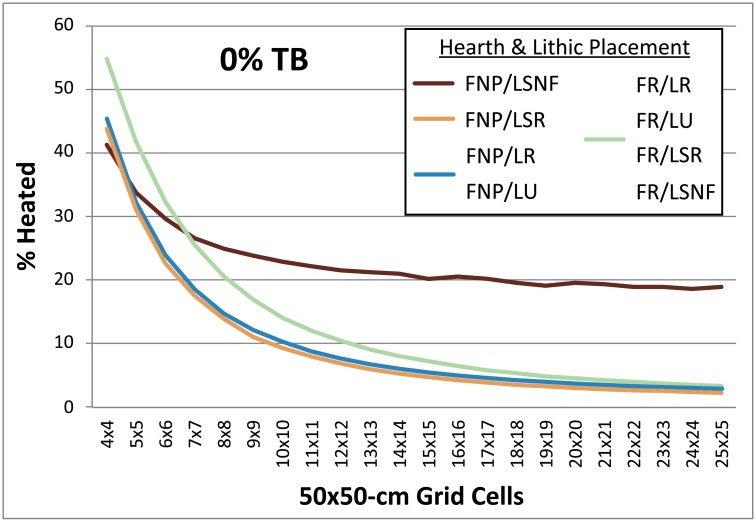
Chart comparing occupation surface size and various fire and lithic scatter placement scenarios.Parameters: 1 fire, fire size 1, 4 lithic scatters, 30 occupations, 1% introduced lithics. Given the near identical results obtained for simulations using the FNP/LR and FNP/LU settings (blue), as well as for all simulations using the FR setting (green), for the sake of clarity these are shown here as single curves. FNP = Fire near previous, FR = Fires random, LSNF = Lithic scatters near fire, LSR = Lithics scatters random, LR = Lithics random, LU = Lithics uniform, TB = Thermal buffering.